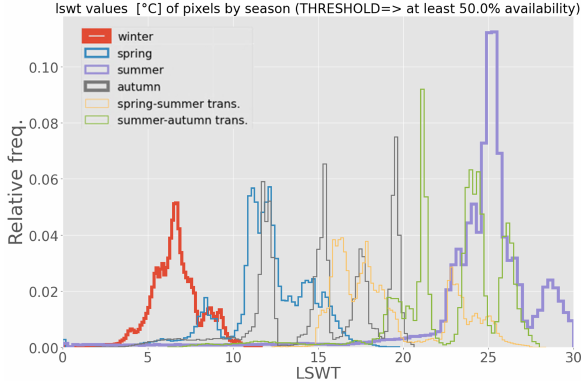
Figure 13. Histograms per season- LSWT (Lake Lugano).